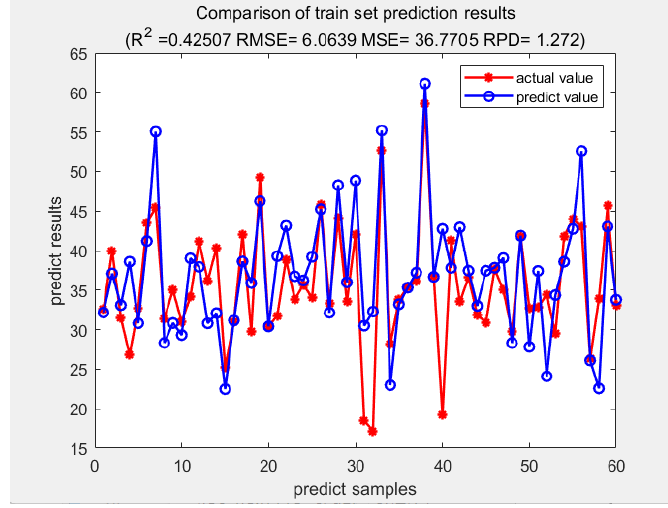
Figure 7. Actual value and predicted value in the training set. Table 1. Dataset of the input output